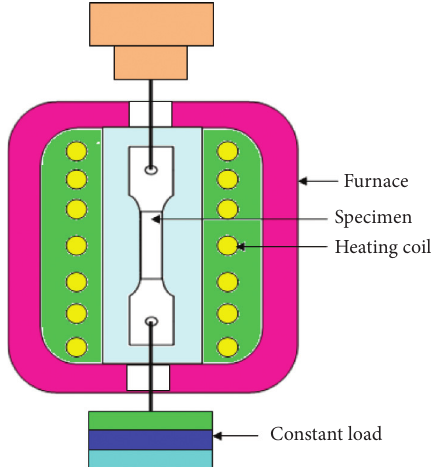
Figure 3: Creep aging